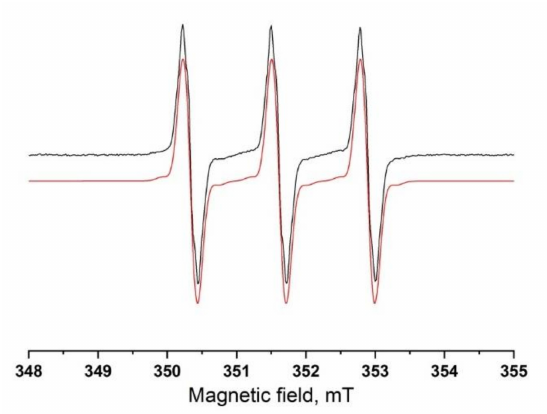
Figure 2. Experimental (black curve) and simulated (red curve) electron spin resonance (ESR) spectra of 4 .